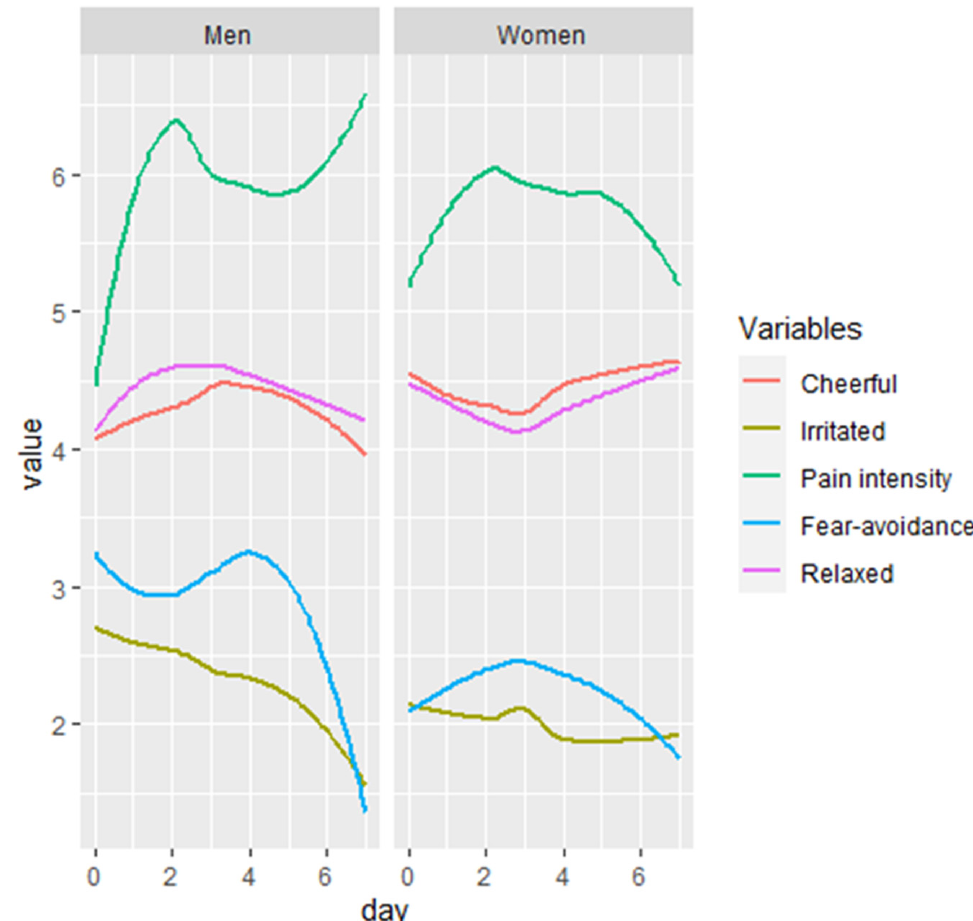
Figure 4. Visualization of the fluctuation of pain intensity, fear avoidance and affective experiences for men and women separately. Note: fear-avoidance and the affective experiences are measured on a 7-point Likert scale and pain intensity is measure on the eleven-point numeric rating scale. Each line represents the average of the 10 beeps per day per